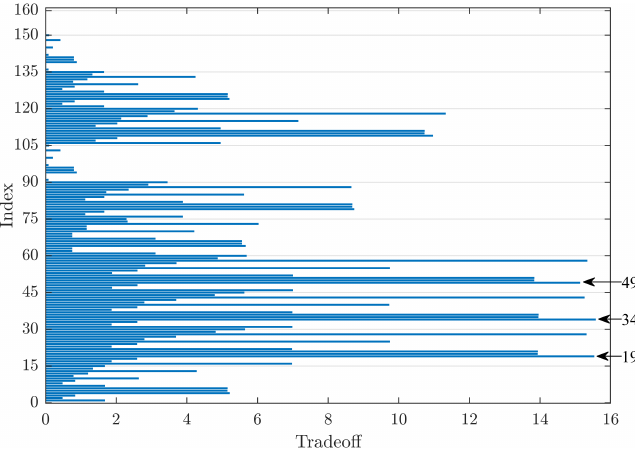
Figure 8. Comparison of TO values for healthy